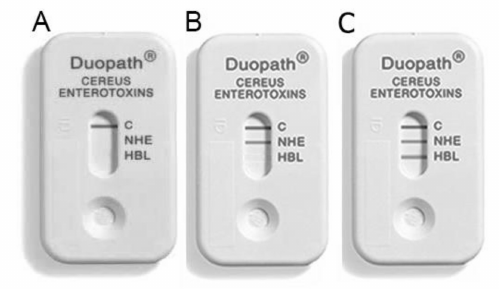
Figure 6. Example of Duopath ® lateral flow kit that detected the absence of enterotoxin ( A ), the presence of Nhe ( B ) and the presence of both Nhe and Hbl enterotoxins ( C